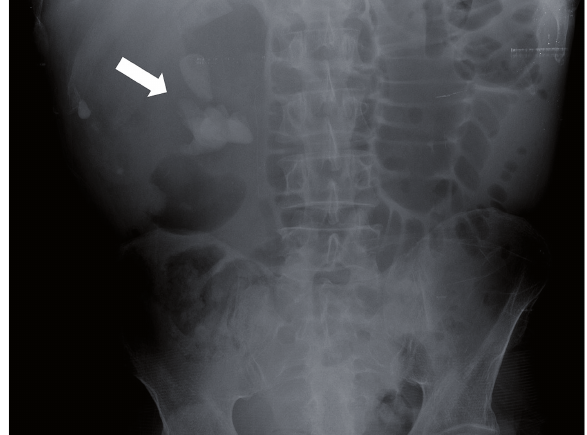
figure 1 - Abdominal radiography demonstrates staghorn calculus in right kidney.